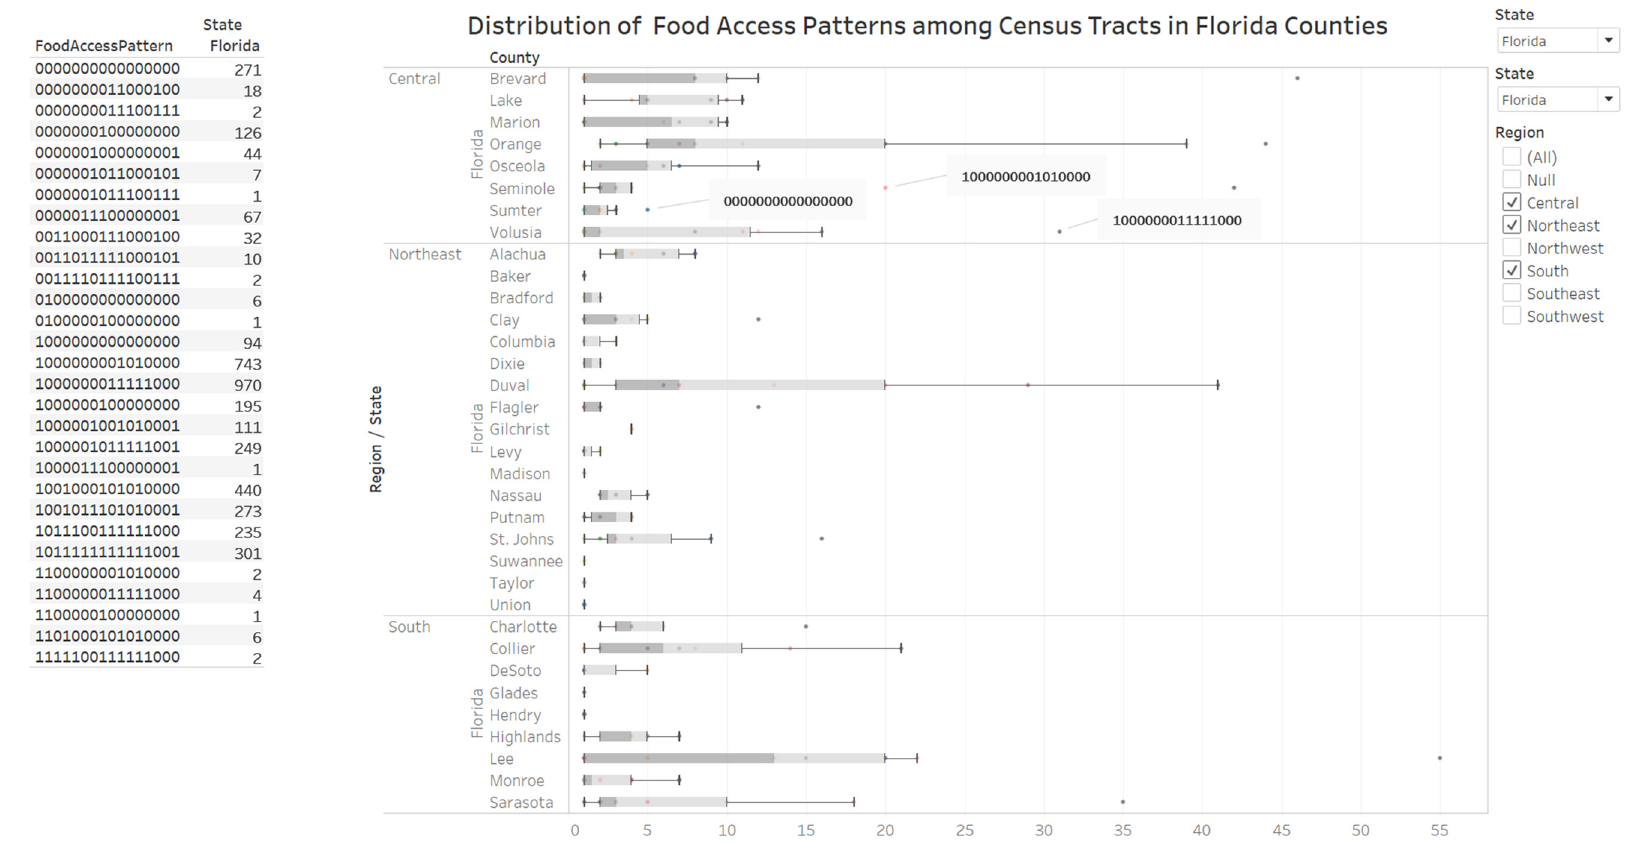
Figure 5. Distribution of food access patterns among census tracts in counties. The dashboard integrates the list of food access patterns and a box plot of the distribution of counts of census tracts with specific food access patterns. In this example, there are 29 food access patterns in Florida (recall function for knowledge visualization). The outlier patterns of food access indicate over-represented food access patterns. Census tracts with food access pattern 1000000011111000 (urban census tract flagged for low access variables) was over-represented (31 out of 113) in Volusia county of Florida.